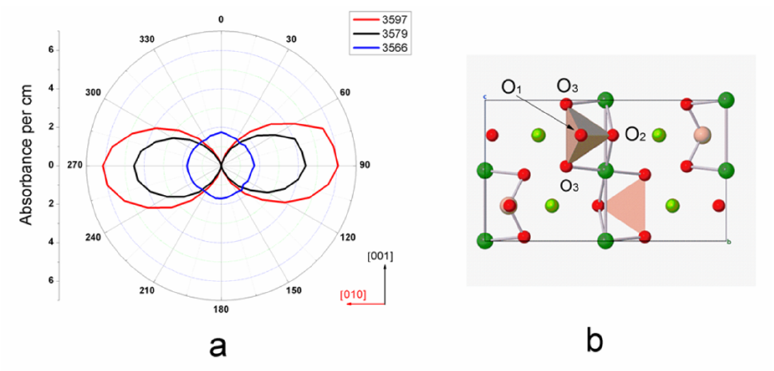
Figure 6. ( a ) The pleochroic scheme of the OH stretching band of the (010) plane of the studied forsterite (absorbance intensity vs. sample to polarizer angle). ( b ) Top view of the atomic structure of the (010) plane of forsterite crystals.